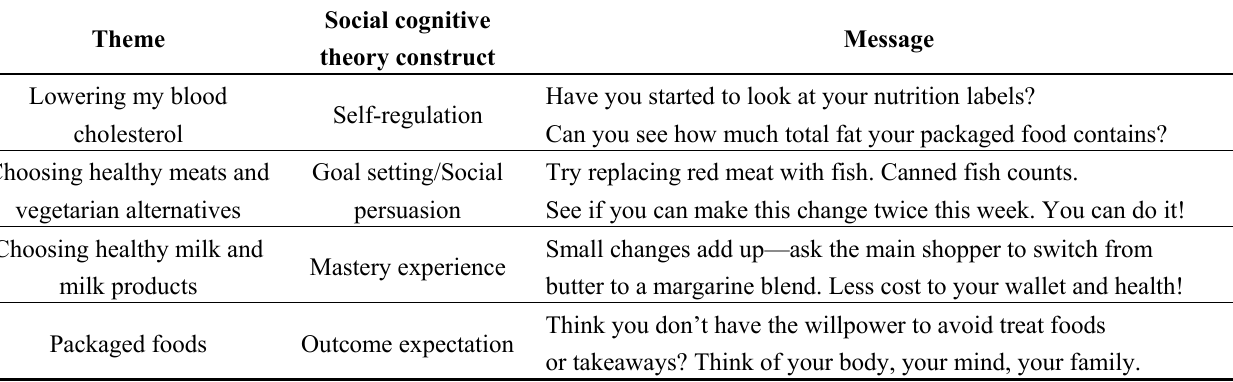
Table 1. Example text